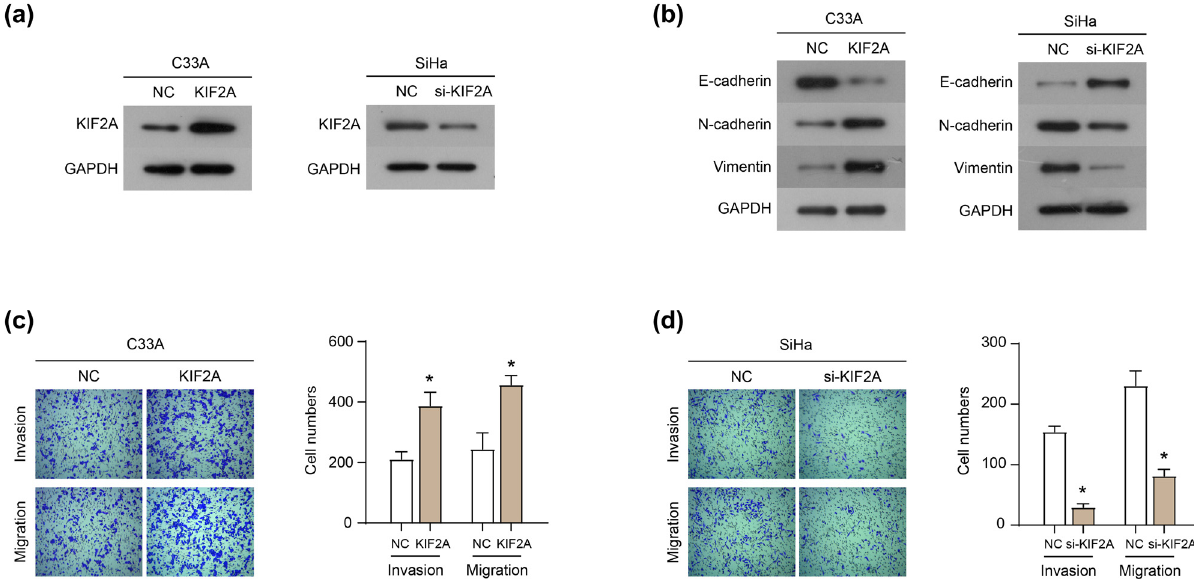
Figure 1: KIF2A facilitates migration and invasion of C33A and SiHa cells. ( a ) Expression of KIF2A in C33A and SiHa cells were overexpressed and knocked down, respectively. ( b ) Expression of EMT - related proteins in C33A and SiHa cells. The invasion and migration of C33A ( c ) and SiHa ( d ) cells. * P <